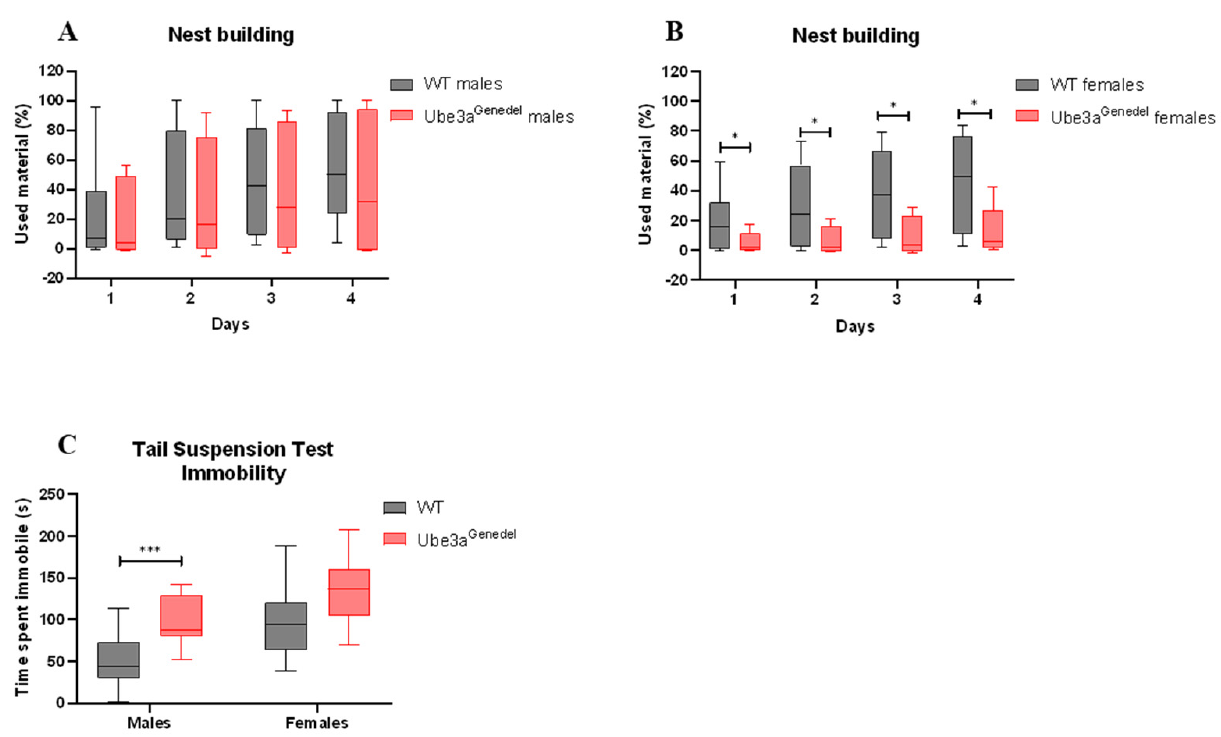
Figure 4. Results from nest building and tail suspension tests. ( A , B ) The Ube3a genedel mice used significantly less material for nesting; robust ANOVA of aligned rank transformed data with dependent measurements, genotype main effect, p < 0.05, depicted with medians and interquartile ranges. ( C ) Ube3a genedel mice spent significantly more time immobile during the last four minutes of the test; two-way ANOVA with dependent measurements, genotype main effect, p < 0.001, depicted with means ± SD. Significant effects of genotype are indicated as * p < 0.05 and *** p < 0.001 for genotype significance.